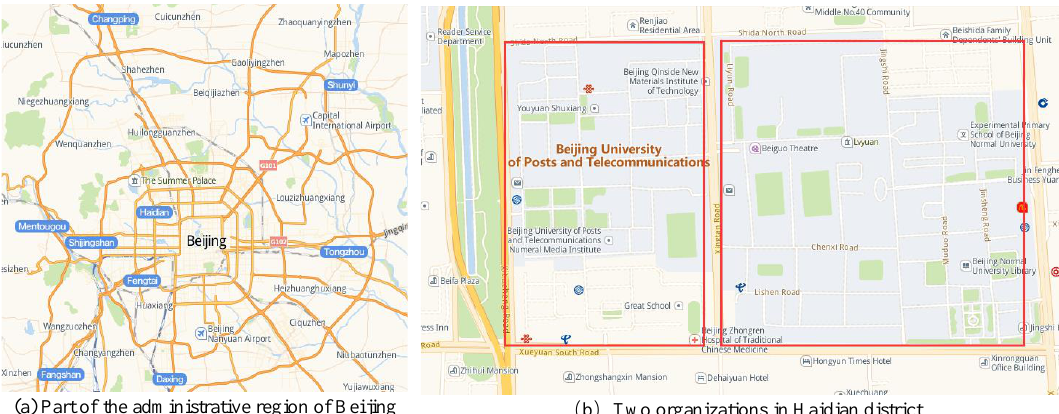
Figure 4. Two levels of hierarchical structure